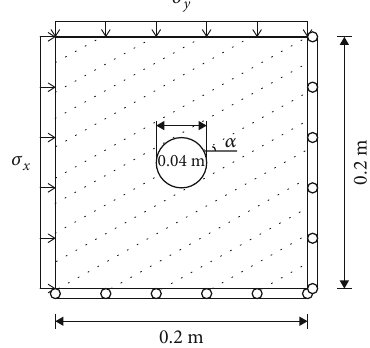
Figure 6: The numerical geometry for fracturing